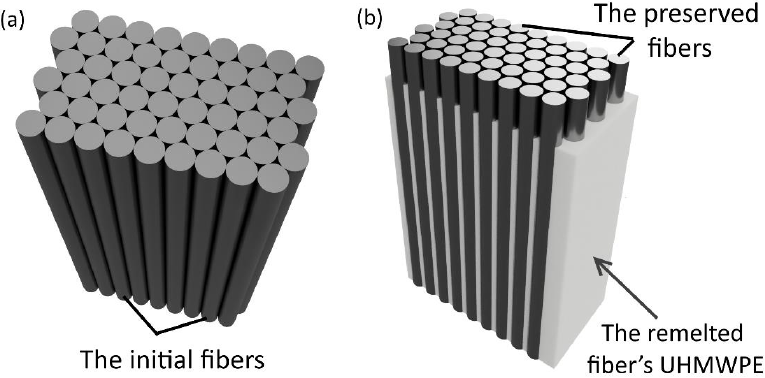
Figure 2. Scheme of the self-reinforced composite (SRC) preparation: initial UHMWPE fiber ( a ) and self-reinforced composites after hot compaction ( b